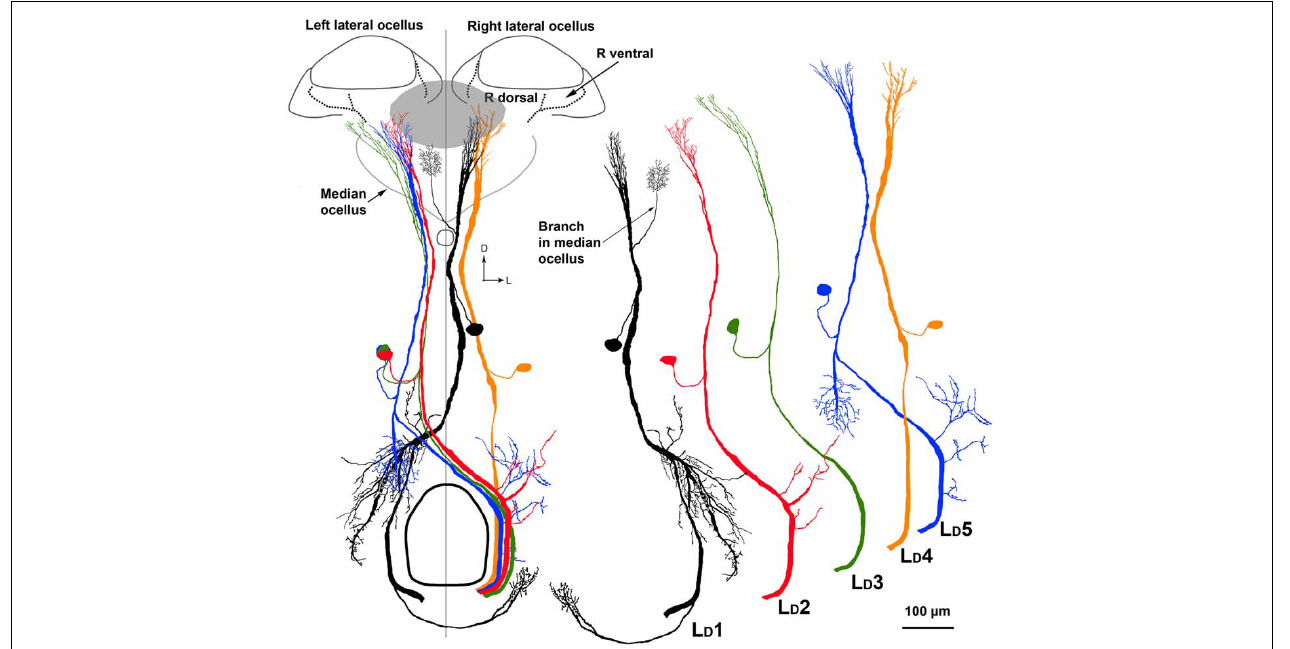
gray patch shows the location of the dorsal retina of the median ocellus. On the right are individual drawings of the five cell types, to allow future identification. Scale bar = 100 µ